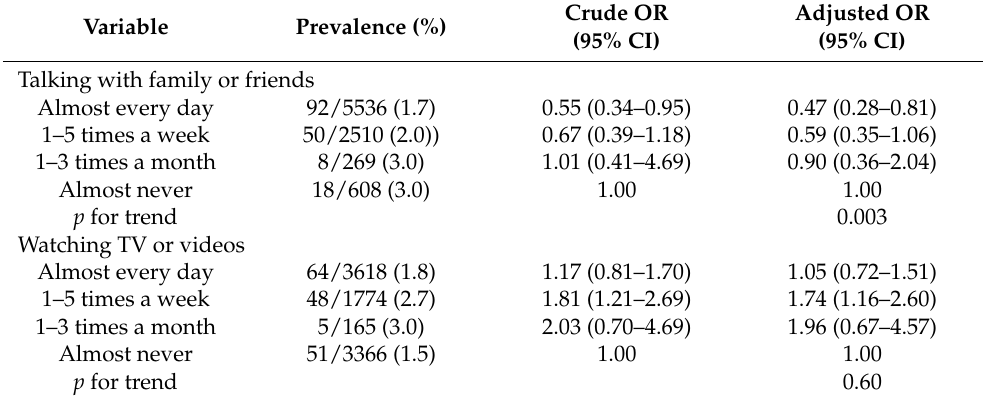
Table 3. Crude and adjusted odds ratios and 95% confidence intervals for functional dyspepsia in relation to type of laughter-inducing